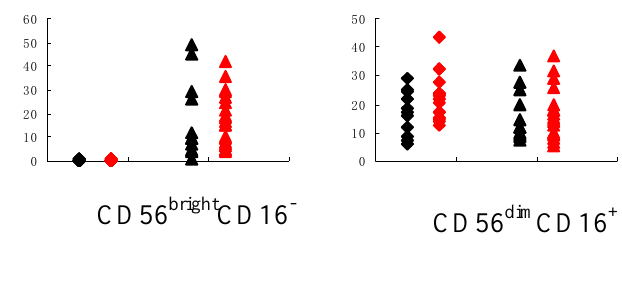
Figure 2 . Individual percentages of NK cell subsets in lymphocytes from preecalmptic patients and the controls. Rhombus, in peripheral blood. triangle, in deciduas. Black, the controls (n = 11). Red, the preeclamptic patients (n =